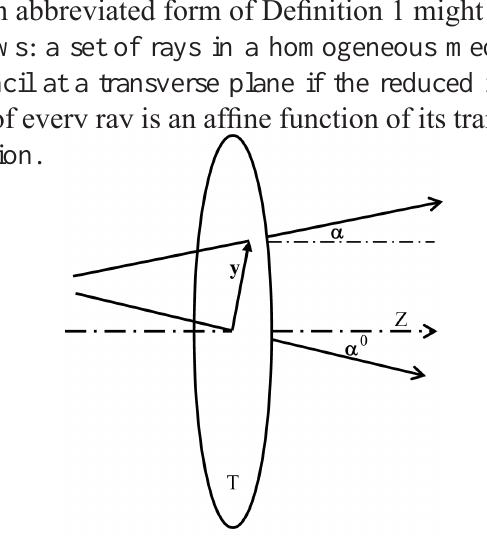
Figure 2 A set of rays intersecting a transverse plane T. Only two of the rays are shown explicitly. One has position vector y and reduced inclination , both being relative to the longi- tudinal axis Z. The other ray intersects T in Z and has reduced inclination 0 . If there exists a matrix M such that Equation 14 holds for every ray in the set then the set is a pencil at T and